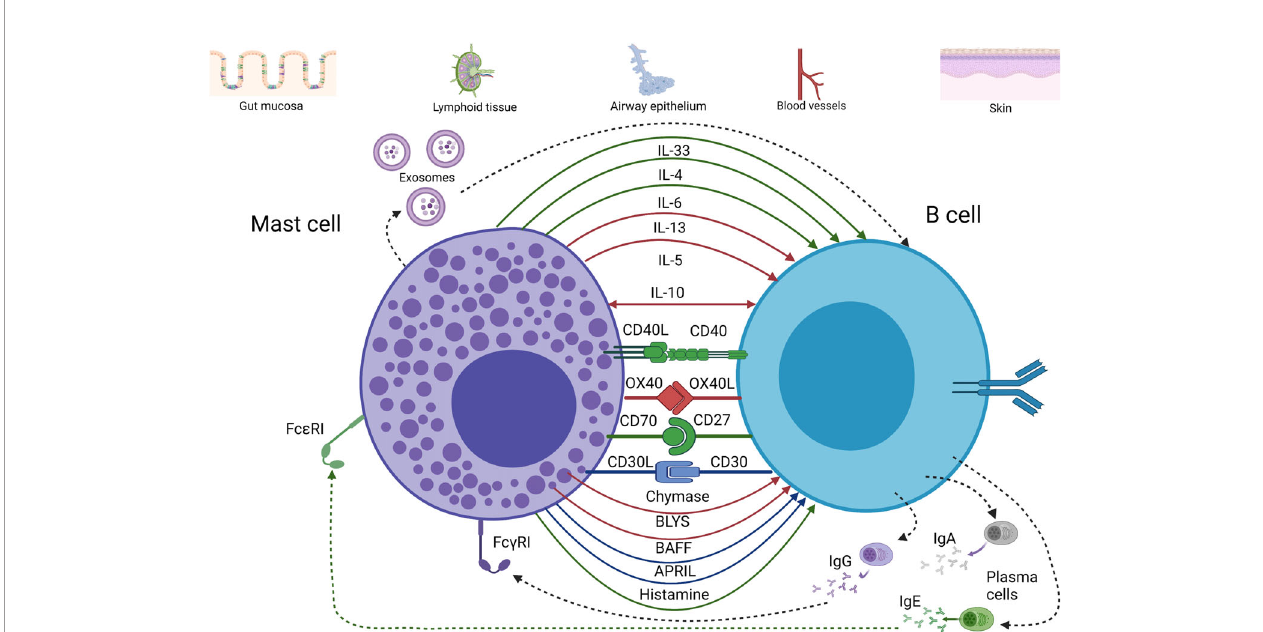
FIGURE 1 | Major pathways of communication between mast cells and B cells. Evidence of cytokine and receptor-ligand interaction between mast cells and B cells has been depicted according to the following color scheme: red for evidence found in rodents, blue for evidence found in humans, and green for rodents and humans. Interaction between mast cells and B cells can occur at mucosal sites as well as at lymphoid and vascular tissues (although less frequently than at the mucosa). This is achieved by a broad array of cytokines (mainly type 2 cytokines, IL-10, IL-6, and IL-33), membrane-bound receptors and ligands (e.g., CD40/ CD40L), and granule products such as histamine and proteases. These interactions can promote B cell proliferation, survival, class-switch to IgA or IgE, among other impacts. In addition, exosomes from both mast cells and B cells may be involved in communication between these cells. ( Figure was prepared using BioRender